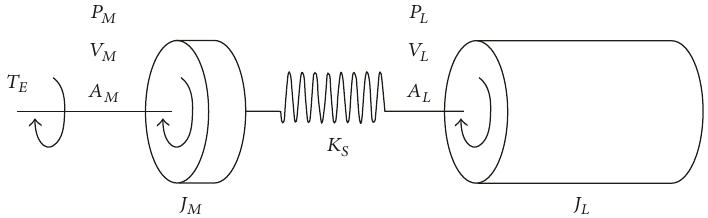
Figure 1: Diagram of compliant coupling between motor and load.